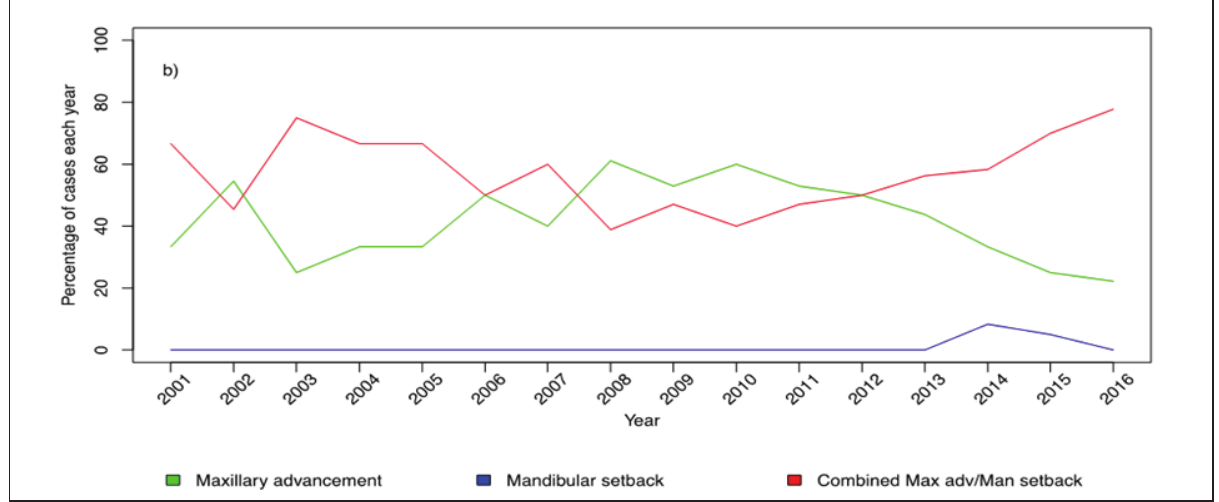
Figure 3. Percentage of cases for each surgery type between 2001 and 2016.